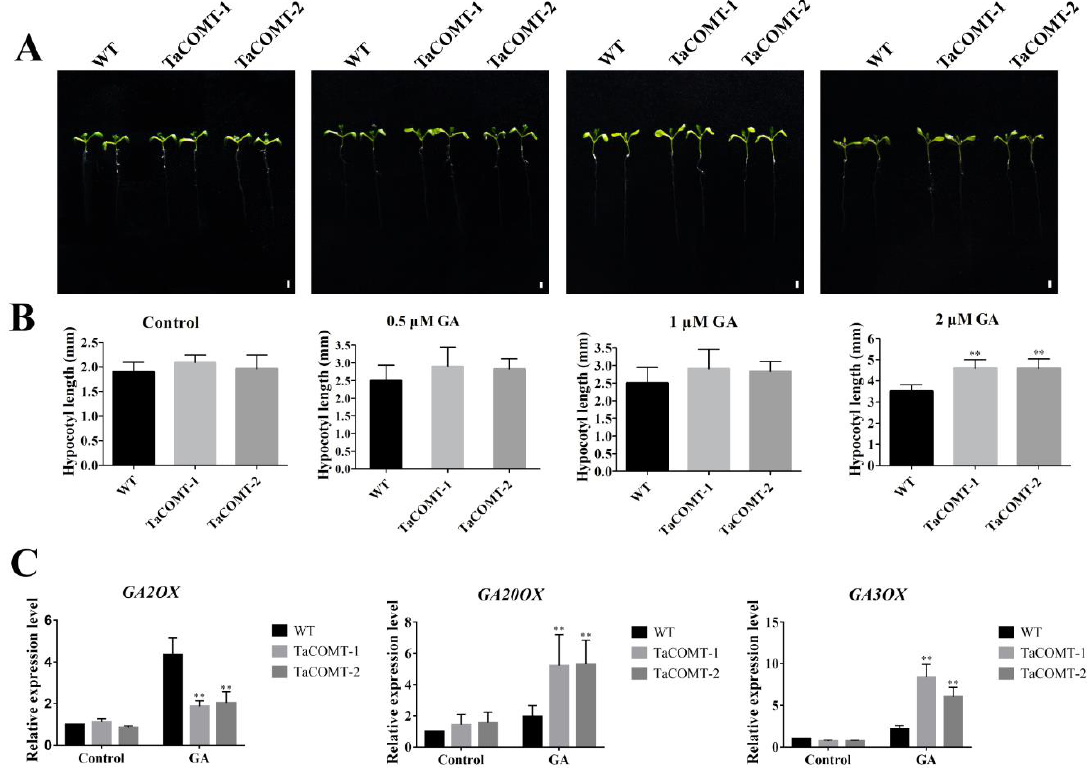
Figure 7. Hypocotyl length and expression of GA-associated genes under GA treatment in Arabidopsis . Phenotypes of WT and TaCOMT transgenic Arabidopsis seeds growth on medium containing 0, 0.5, 1 and 2 µΜ GA for a week (bar = 2 mm) ( A ). Statistical results of hypocotyl length of WT and transgenic plants treated with different concentrations of GA ( B ). Two-week-old Arabidopsis seedlings were transferred to ½ MS medium containing 100 µM GA for 24 h, and then the transcription level of GA-responsive genes was analyzed ( C ). Expression of AtActin as a loading control. At least 25 seedlings per phenotype were counted. The data were shown as the means ± SDs ( n = 25) of three experiments. An ANOVA test showed significant differences (* p < 0.05, ** p < 0.01).